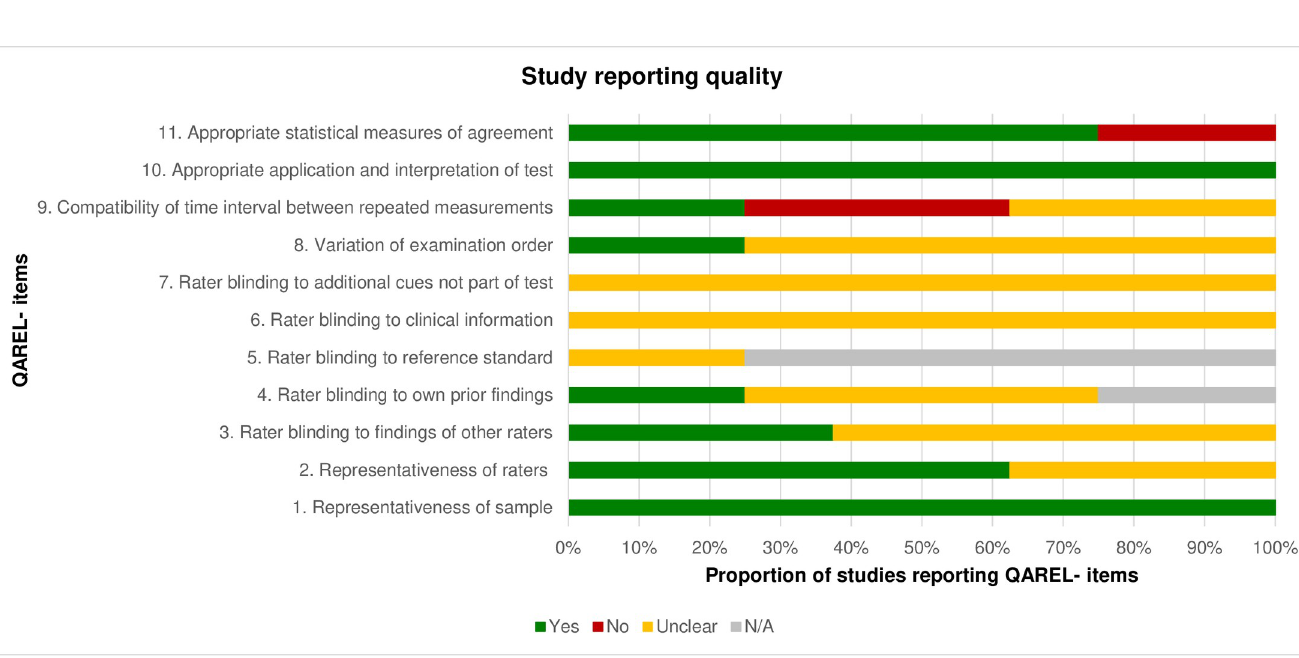
PLOS ONE | https://doi.org/10.1371/journal.pone.0261457 December20,